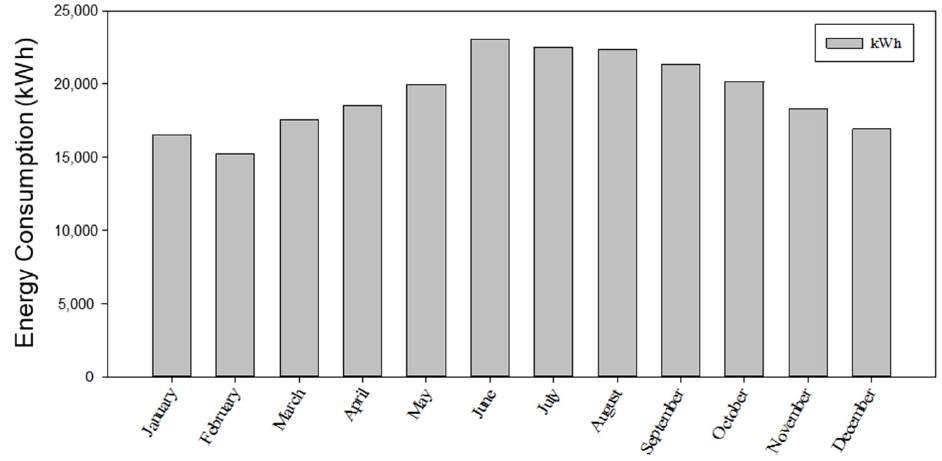
Figure 7. Annual energy consumption of AC.